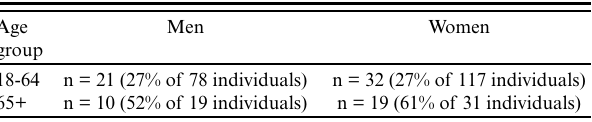
Table 3 . Breakdown of stratified random sample of men and women by age according to total percentage of the population